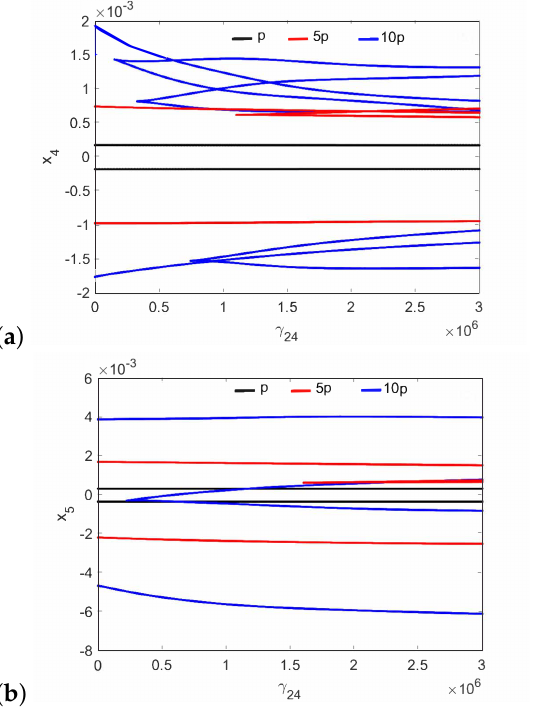
Figure 3. Bifurcation diagrams of the FMT in the normal ear at the first resonance versus the nonlinear stiffness of the coupler ( γ 24 ): the can ( a ), and the magnet ( b ).